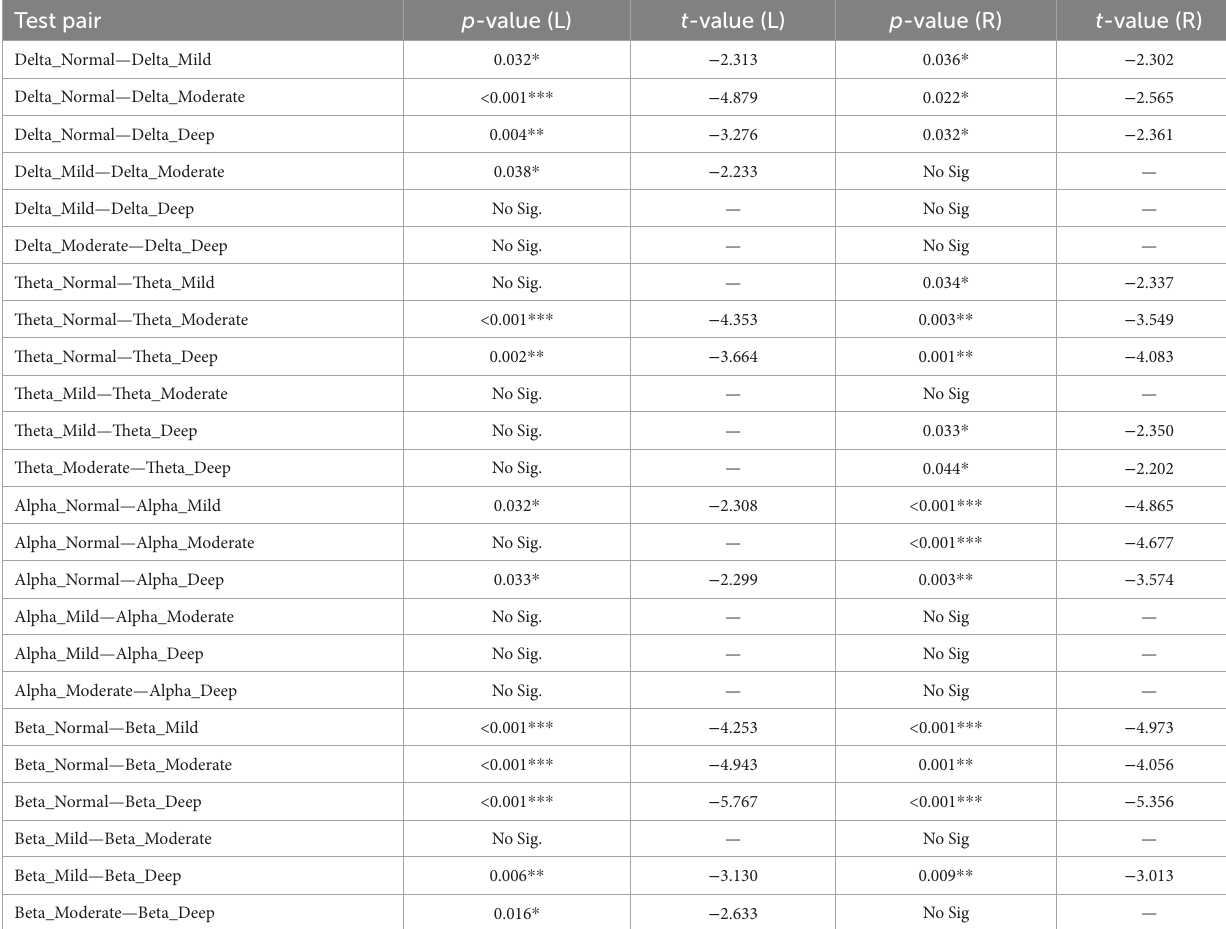
TABLE 2 Value of p and t -value from Pair-sample T -test of all frequency bands under normal driving and different cognitive workloads. Test